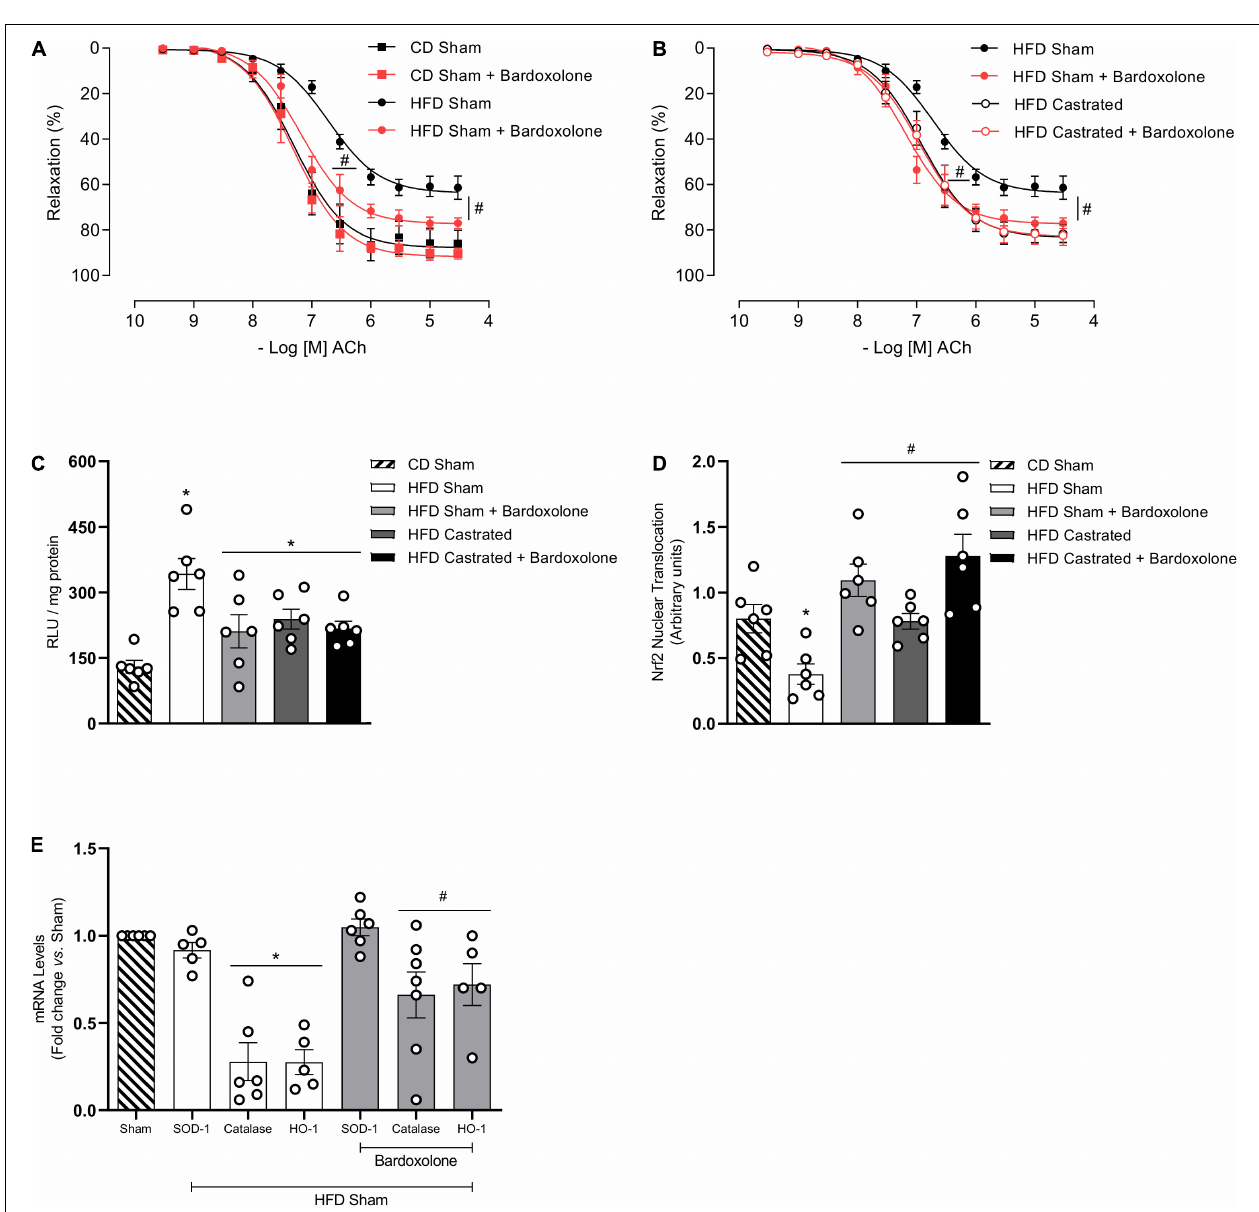
FIGURE 4 | Castration prevents vascular dysfunction in high fat diet (HFD)-fed mice by mechanisms that involve nuclear factor E2–related factor 2 (Nrf2) system activation. Concentration-response curves to acetylcholine (ACh) were performed in aortic rings isolated from control diet (CD) sham, HFD sham and HFD castrated in the presence of Bardoxolone (10 − 6 M) [ (A,B) n = 7 in all groups]. Superoxide anion generation – measured by lucigenin [ (C) n = 6 for each experimental group], nuclear accumulation of Nrf2 [ (D) n = 6 for each experimental group], and mRNA expression of genes regulated by Nrf2 [ (E) n = 5 or 6 for each experimental group] were determined in aortas isolated from mice of the various experimental groups. Data are expressed as mean ± SEM. * p < 0.05 vs . CD Sham; # p < 0.05 vs . HFD Sham.